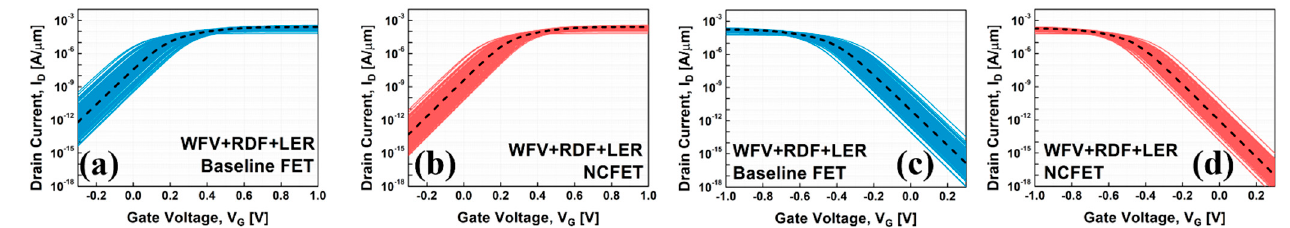
Figure 6. Simulated I DS -V GS curves ( a ) for n-type JL-NWFET (JL) and for ( b ) n-type NC-JL-NWFET (NC-JL) with three random variations (WFV, RDF, and LER). I DS -V GS curves ( c ) for p-type JL-NWFET (JL) and for ( d ) p-type NC-JL-NWFET (NC-JL) with (WFV, RDF, and LER). The dotted line indicates the nominal I DS -V GS for JL-NWFET and NC-JL-NWFET. Table 5. Variation parameters of n-/p-type JL-NWFET and NC-JL-NWFET in linear and saturation mode with combined random variations.